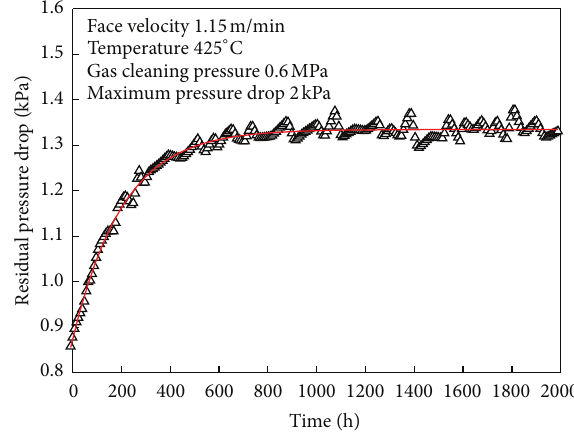
Figure 6: The variations of residual pressure drop during